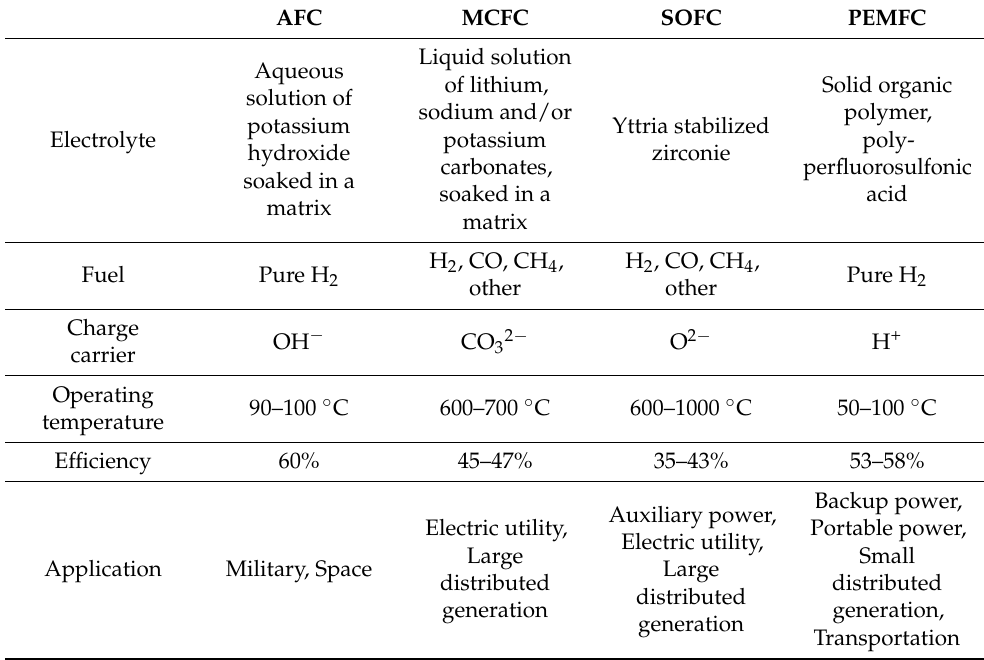
Table 1. Classification of fuel